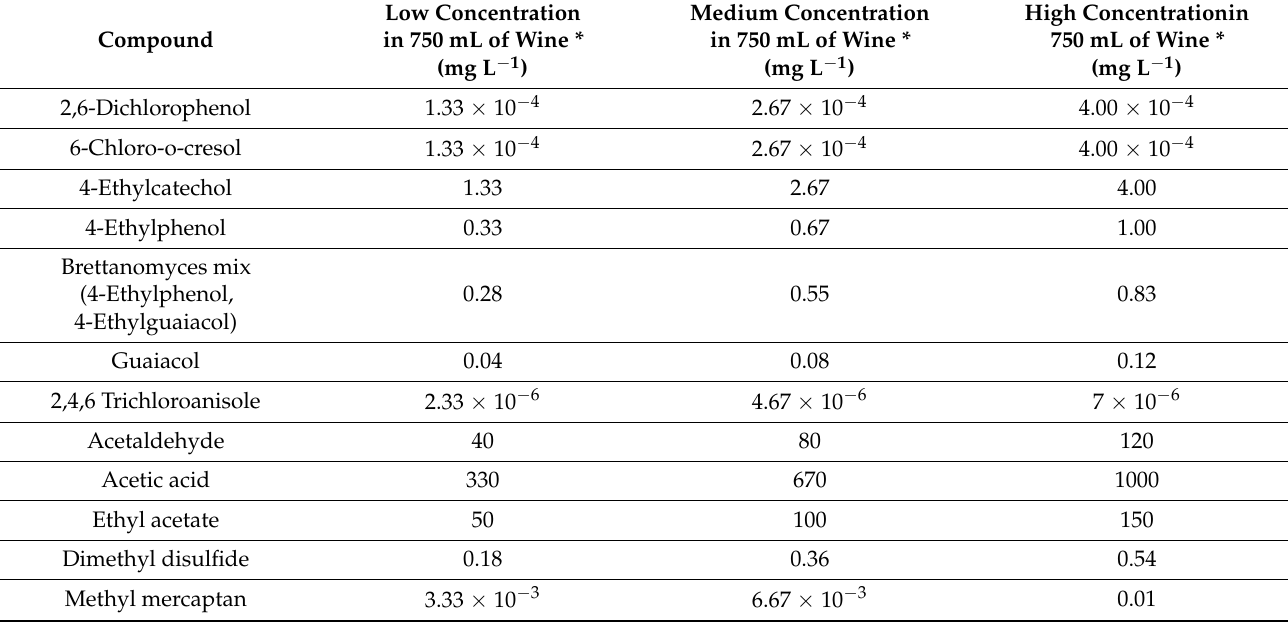
Table 2. Concentrations used for each treatment and faults to spike red and white